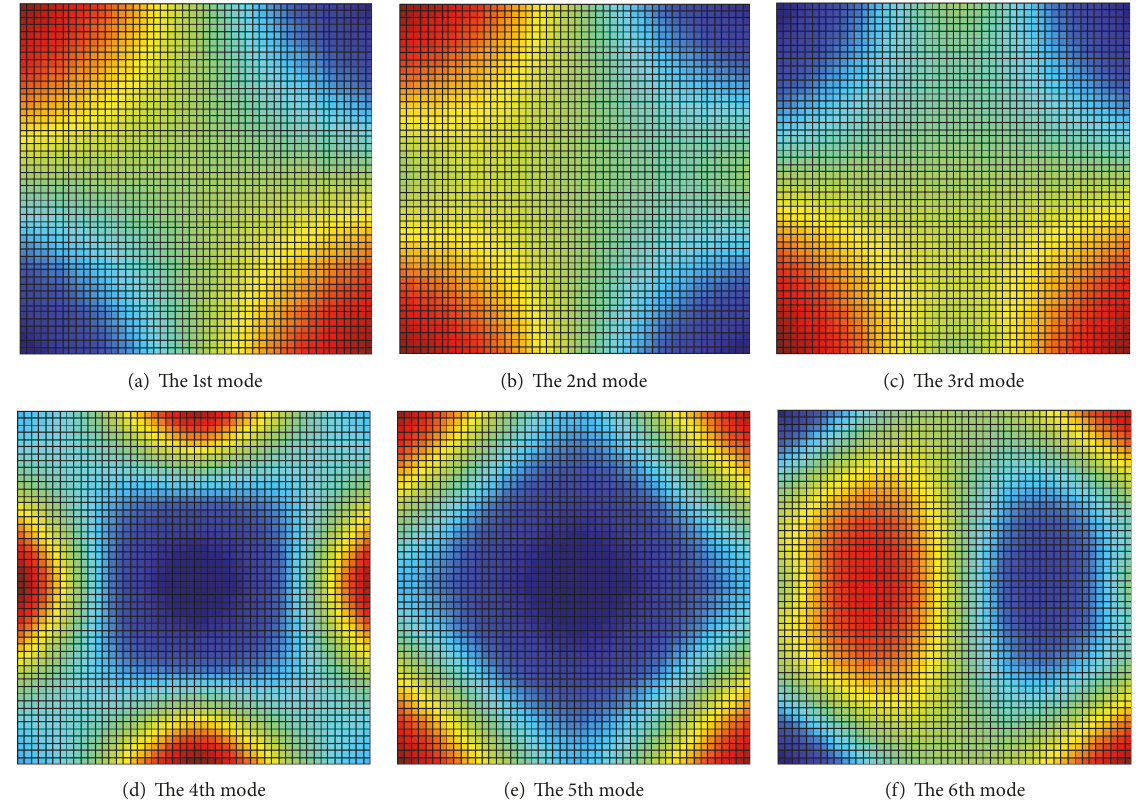
= 𝜉 = 10 8 , 𝜉 = 0 , 𝐾 𝑖 𝐾 𝑖𝑗 𝑖